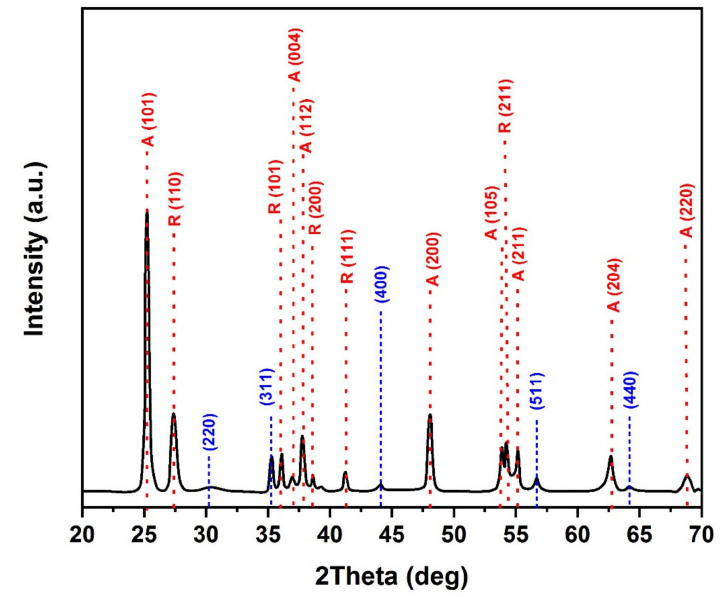
Figure 3. XRD pattern of TSFG after heat treatment at 650 ◦